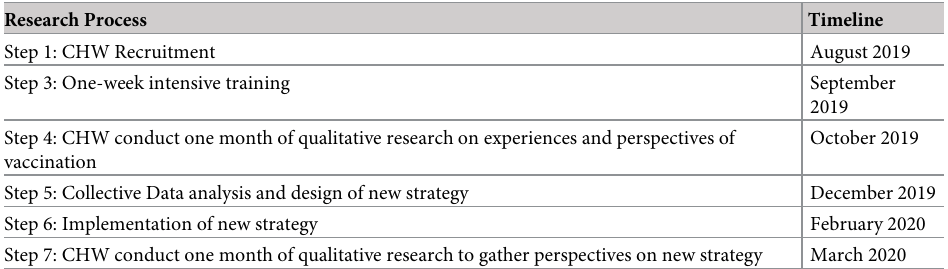
Table 1. Research process and